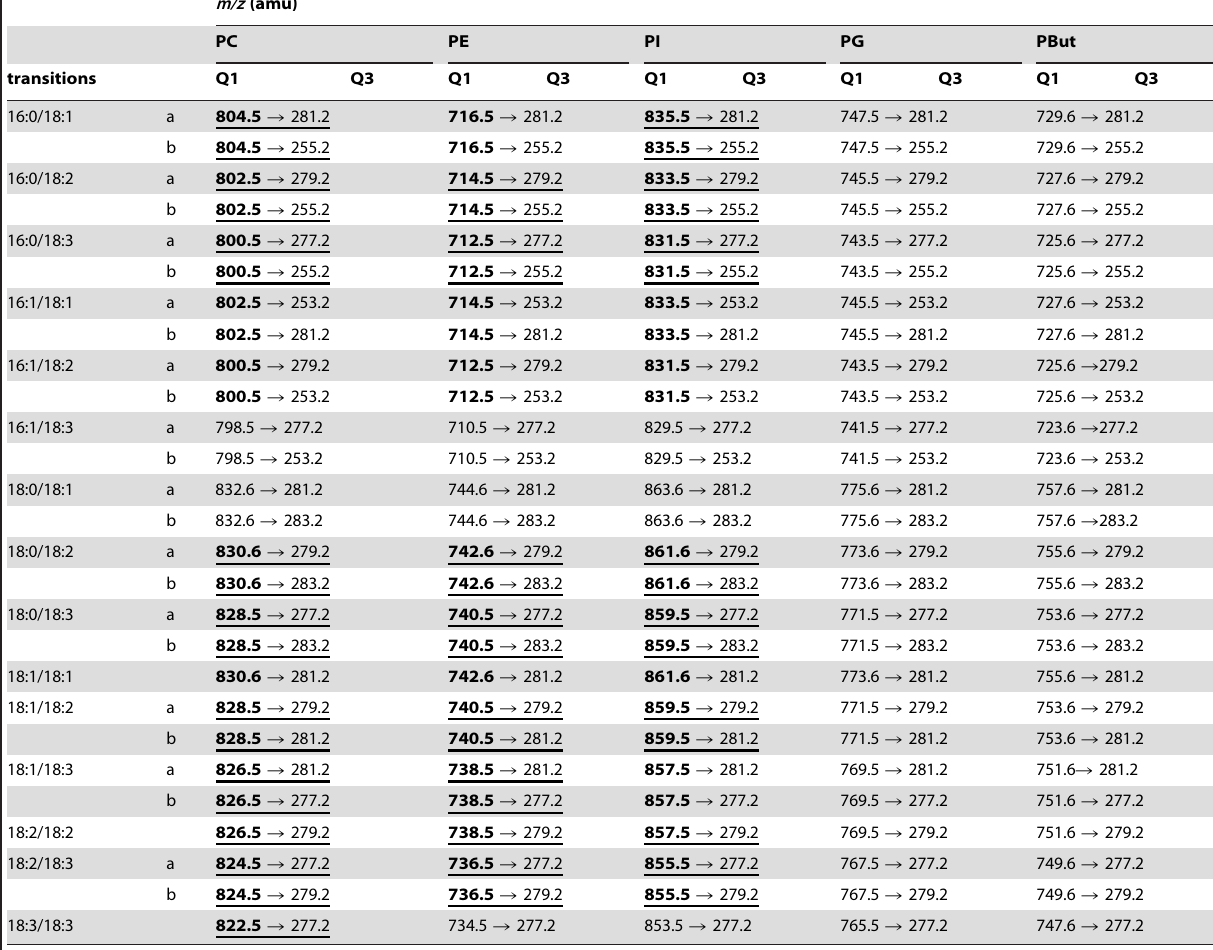
Table 1. List of MRM